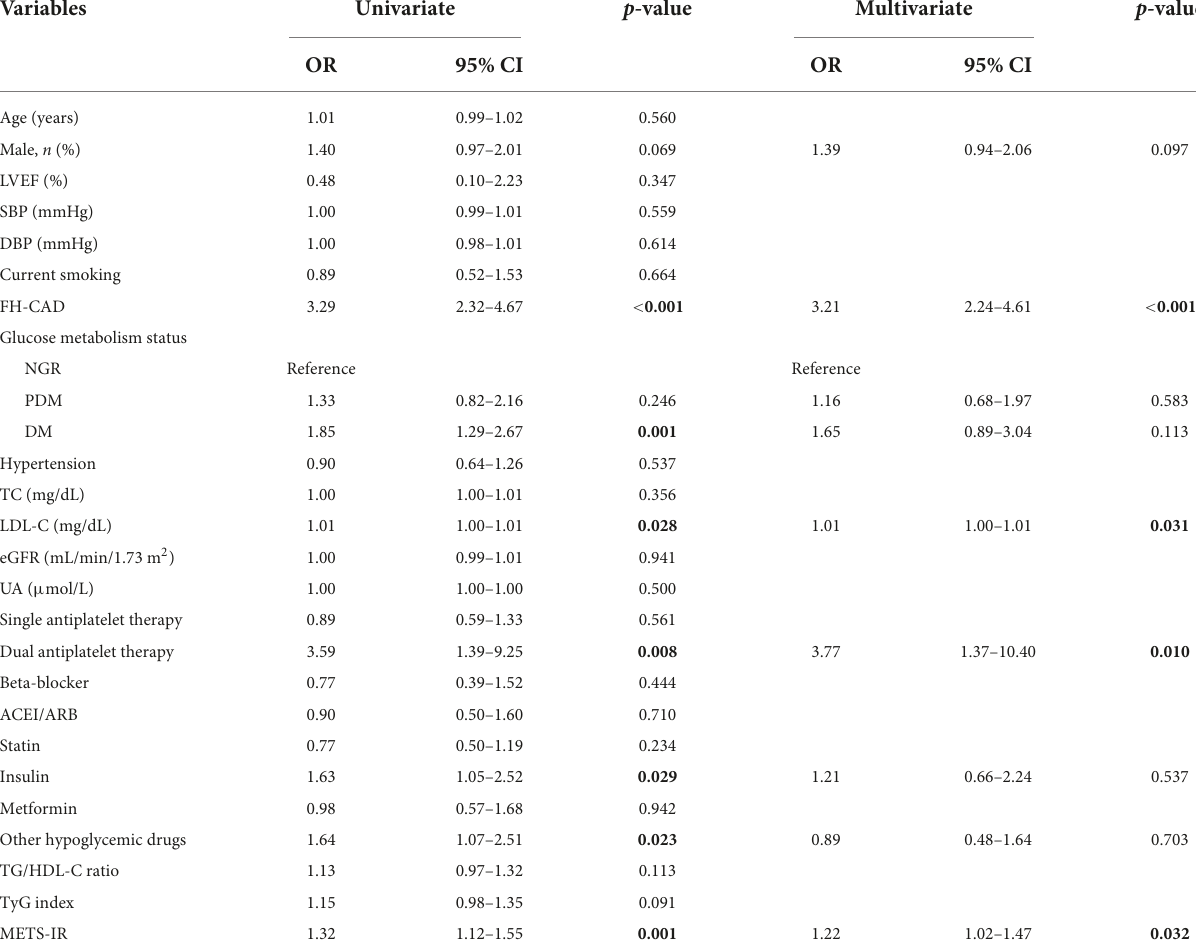
TABLE 5 Univariate and multivariate logistic regression analyses for high